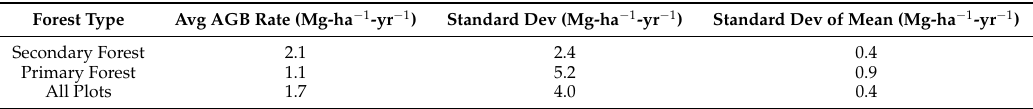
Table 2. Average, standard deviation, and standard deviation of the mean of AGB-rate for secondary, primary, and all forest